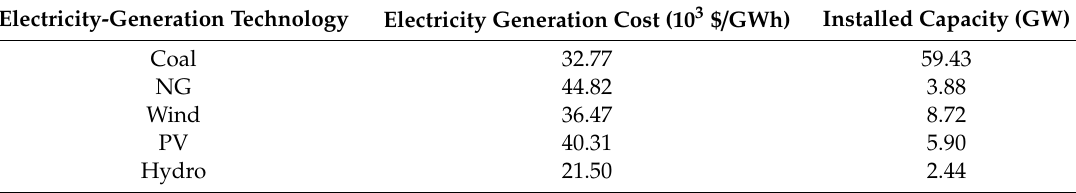
Table 2. Power generation technical parameters.